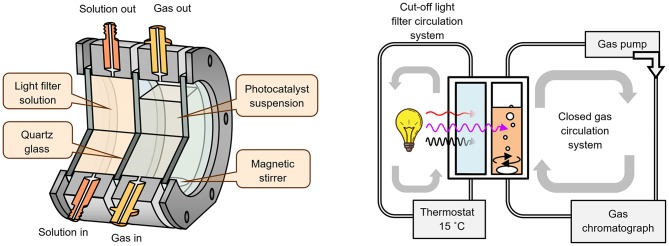
Photocatalytic reaction cell and scheme of the photocatalytic experimental set-up.